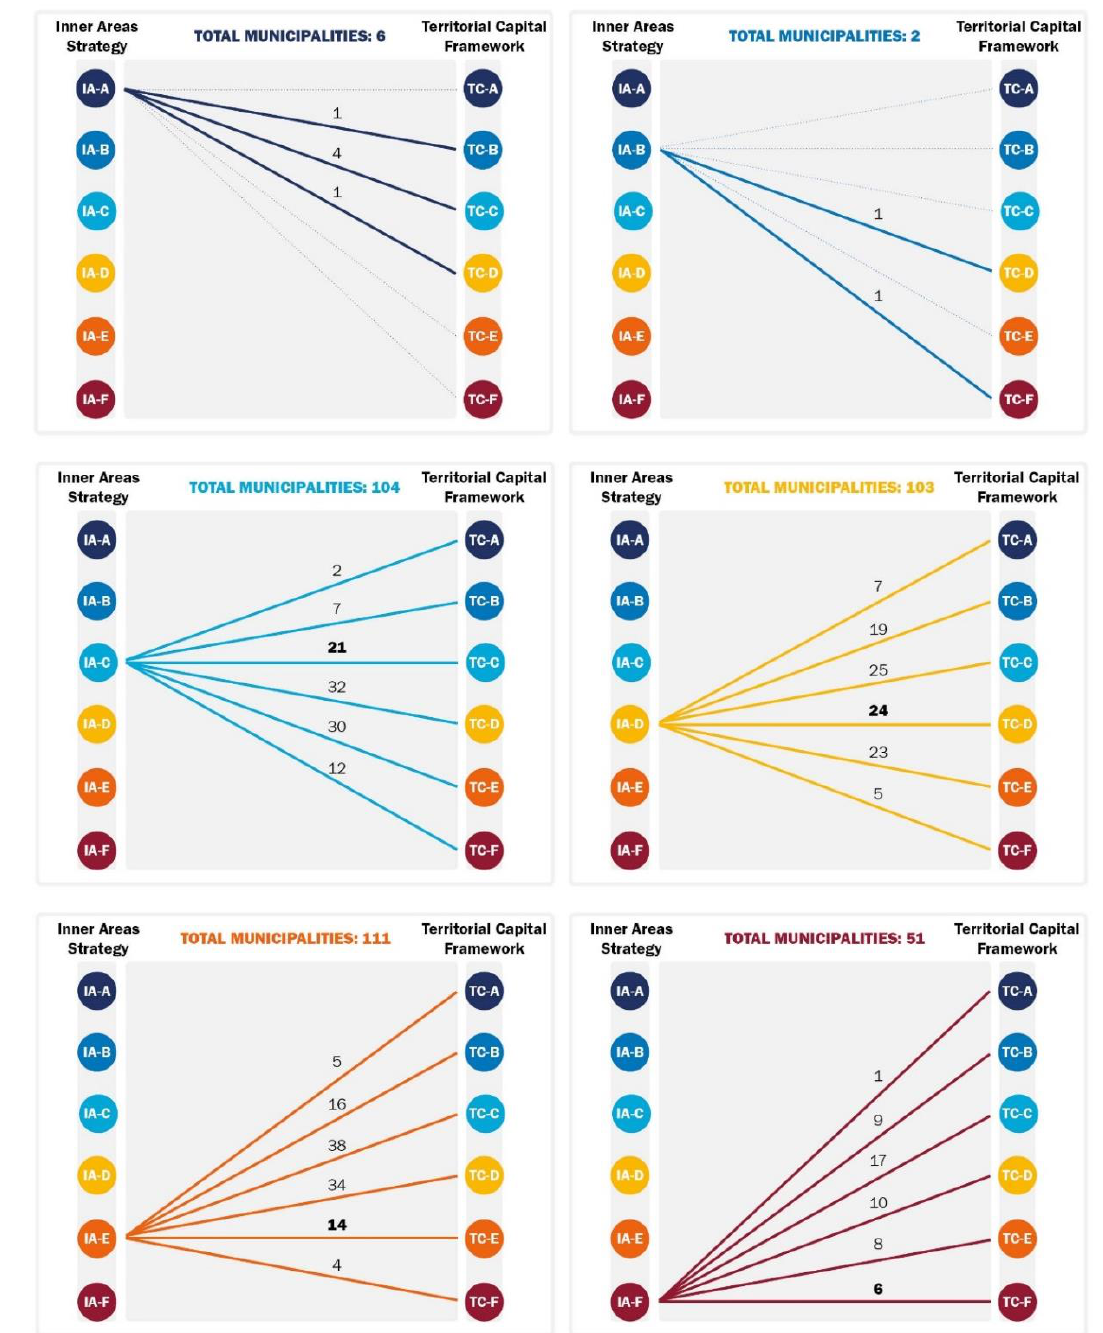
Figure 3. Correspondences between the Strategy for Inner Areas (IA) and Territorial Capital classi- fication (TC).